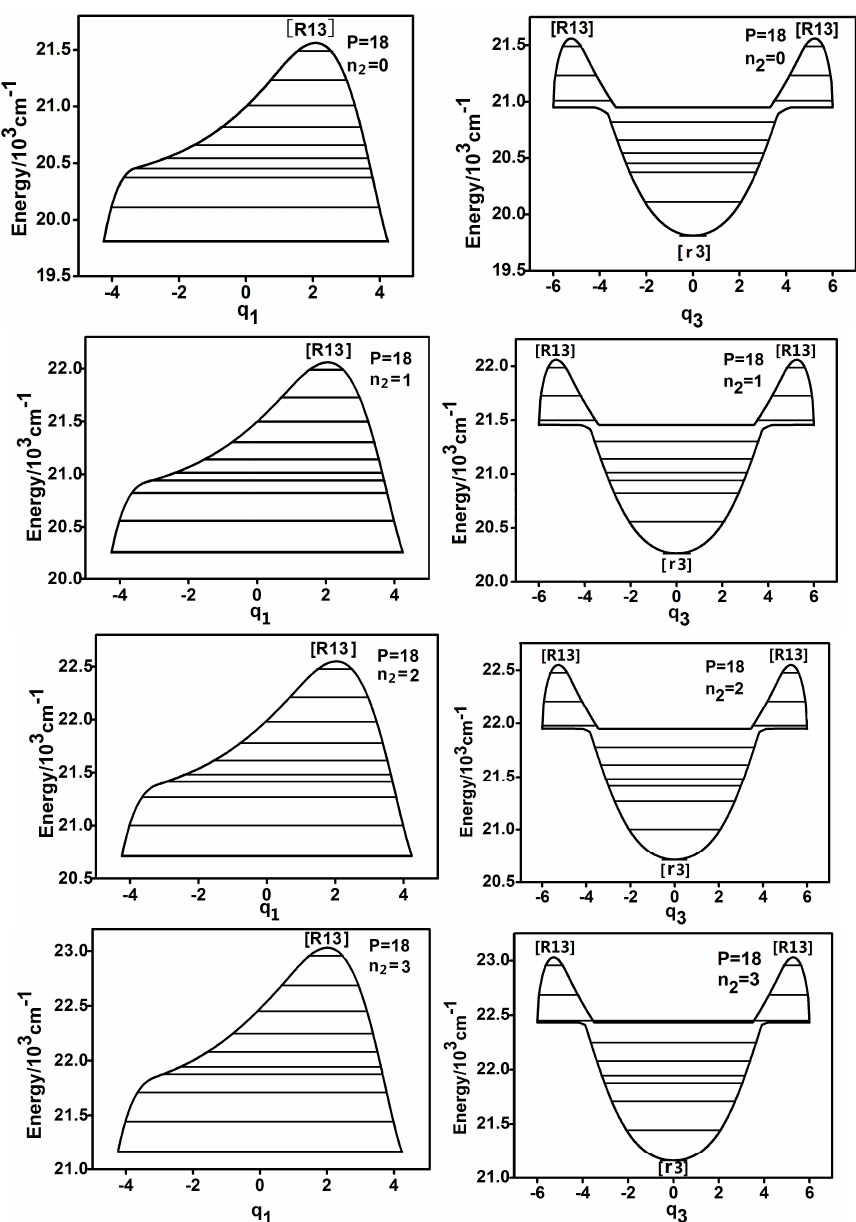
Figure 1. Dynamic potentials of DCP ( P = 18) with n 2 = 0,1,2,3, and the energy levels included in the dynamic potential are shown by the lines.